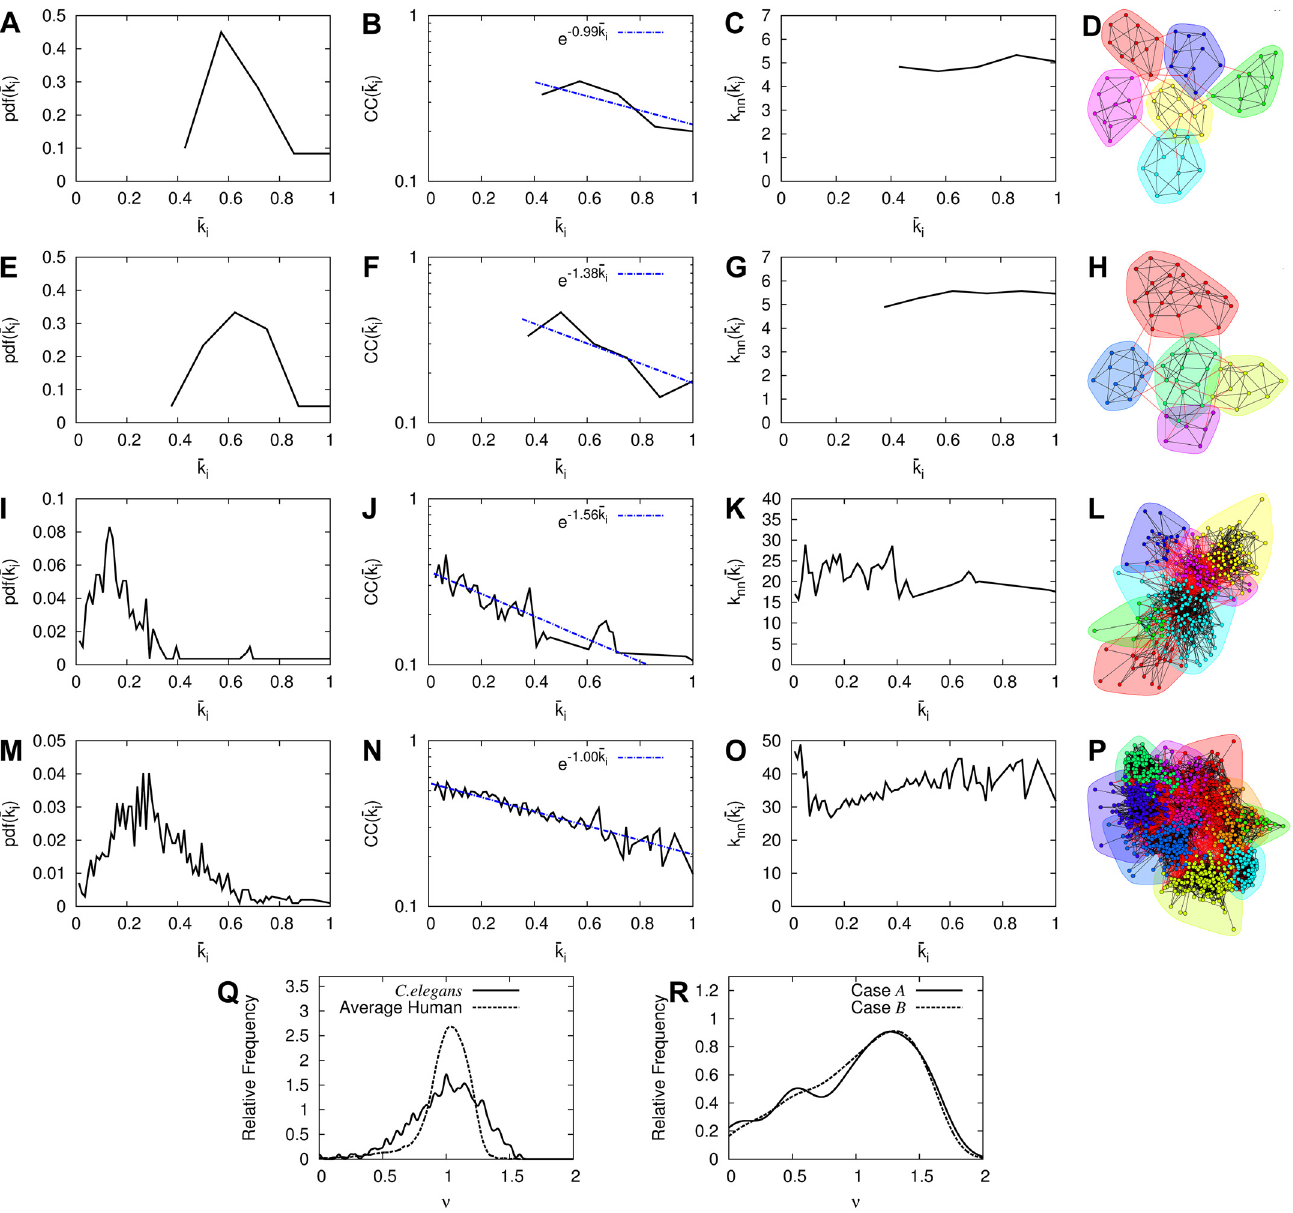
Fig 4. Structural properties and normalized Laplacian spectra of the brain networks considered in this study. Panels (A) to (D): Plot of the pdf of the Þ (panel (B)), plot of the average normalized degree k ð (cid:1) k Þ of the neighbors of nodes (panel (A)), plot of the clustering coef fi cient CC ð (cid:1) k normalized degrees (cid:1) k i i nn i (panel (C)) and the network with its distinct clusters and communities given by different colors for the case A of high with normalized degree (cid:1) k i synchronization and low mMIR of the model for brain network evolution of 60 neurons and 6 clusters. Panels (E) to (H): Same as in panels (A) to (D) but for the case B of low synchronization and high mMIR of the same model. Panels (I) to (L): Same as in panels (A) to (D) but for the C.elegans brain network. Panels (M) to (P): Same as in panels (A) to (D) but for the human subject A 1 brain network. In the plots of the second column, we show with blue dashed lines ¼ k = k ) to (cid:1) k to guide the eye, where (cid:1) k is the normalized degree. It is de fi ned as (cid:1) k , where k i is the node degree and the exponential dependence of CC( (cid:1) k i i i i i max k max is the largest node degree in the network. For the fi rst row, k max = 7, for the second k max = 8, for the third k max = 76 and for the fourth, k max = 87. Panel (Q): Normalized Laplacian spectra of the brain network of C.elegans (solid curve) and of the averaged over the six human subjects (dashed curve). Panel (R): Similarly for the brain network of case A of high synchronization and low information fl ow capacity (solid curve) and, for case B of low synchronization and high information fl ow capacity (dashed curve) of the model for brain network evolution.